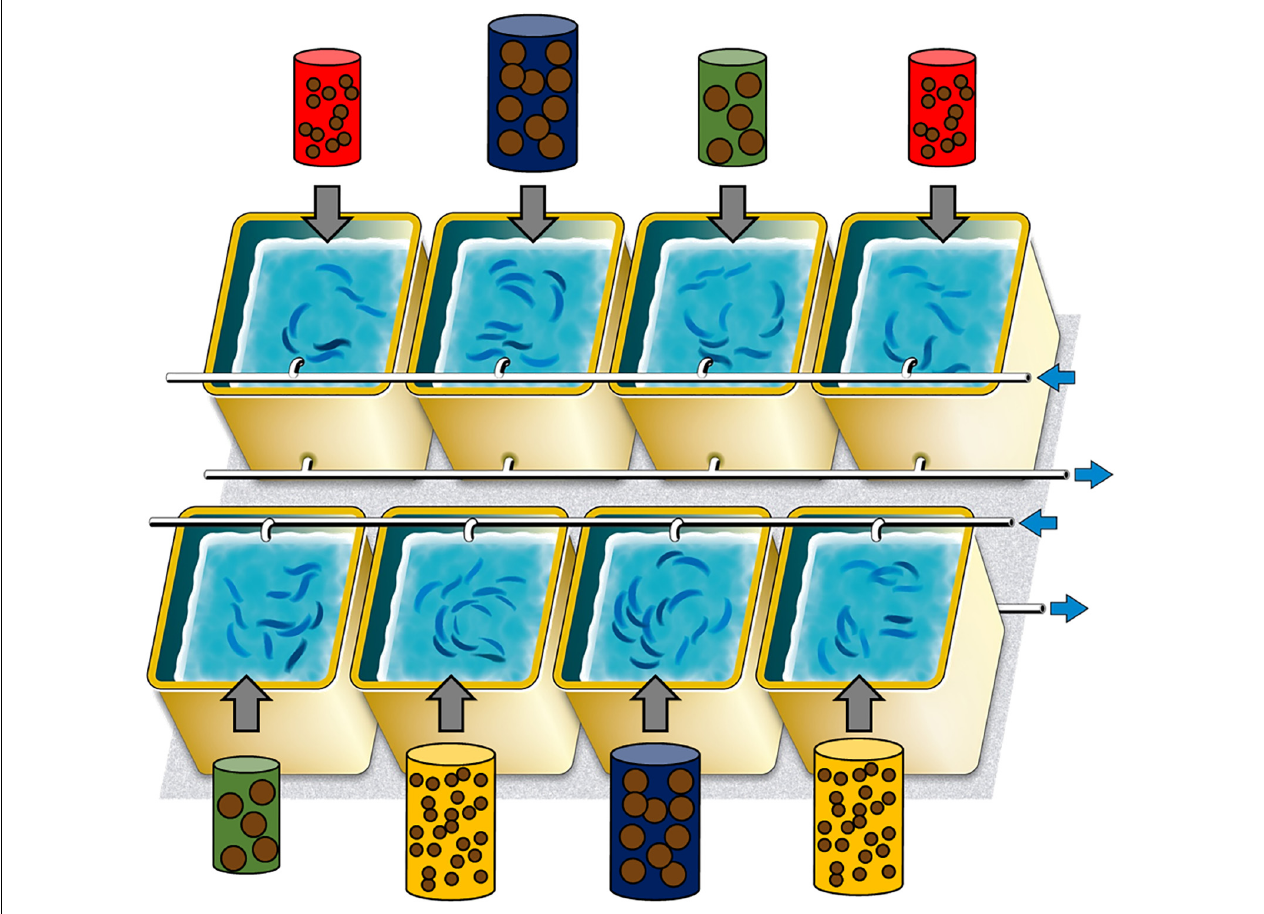
FIGURE 1 | Experimental design to study the impact of food treatment, comprising the 8 tanks and their feeding treatment (red: pellet size of 0.1 mm and pellet quantity of 0.3%; green: 0.1 mm and 0.6%; yellow: 1.2 mm and 0.1% and blue: 1.2 mm and 0.6%). Blue arrows represented input and output sea